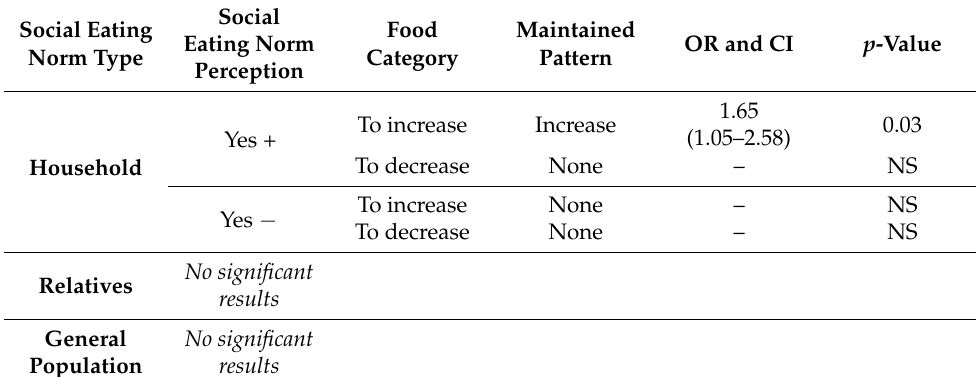
Table 5. Results of multinomial logistic regressions evaluating the influence of lockdown social eating norms on the maintenance on changes for the two food